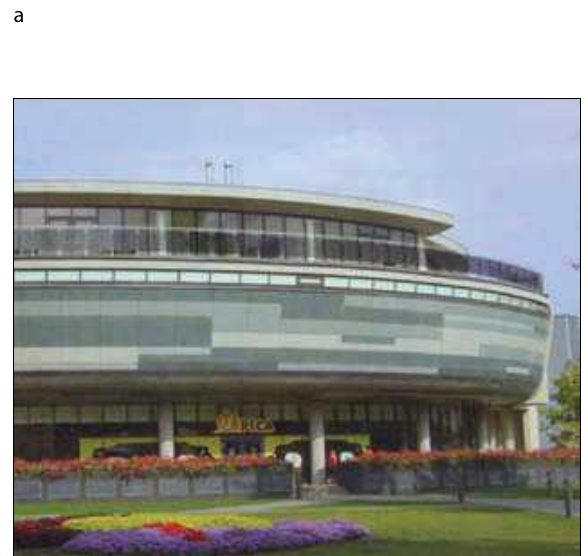
Fig. 6. Former Sanatorium of Physiotherapy in Vilnius avenue (a), today – recreational Water Park (b) (first built in 1981, architects: a. Šilinskas, r. Šilinskas; after renovation in 2006, authors: k. kisielius,